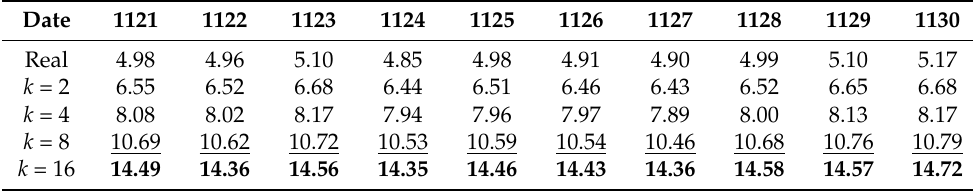
Table 4. The average increased orders in CTPURec with different k